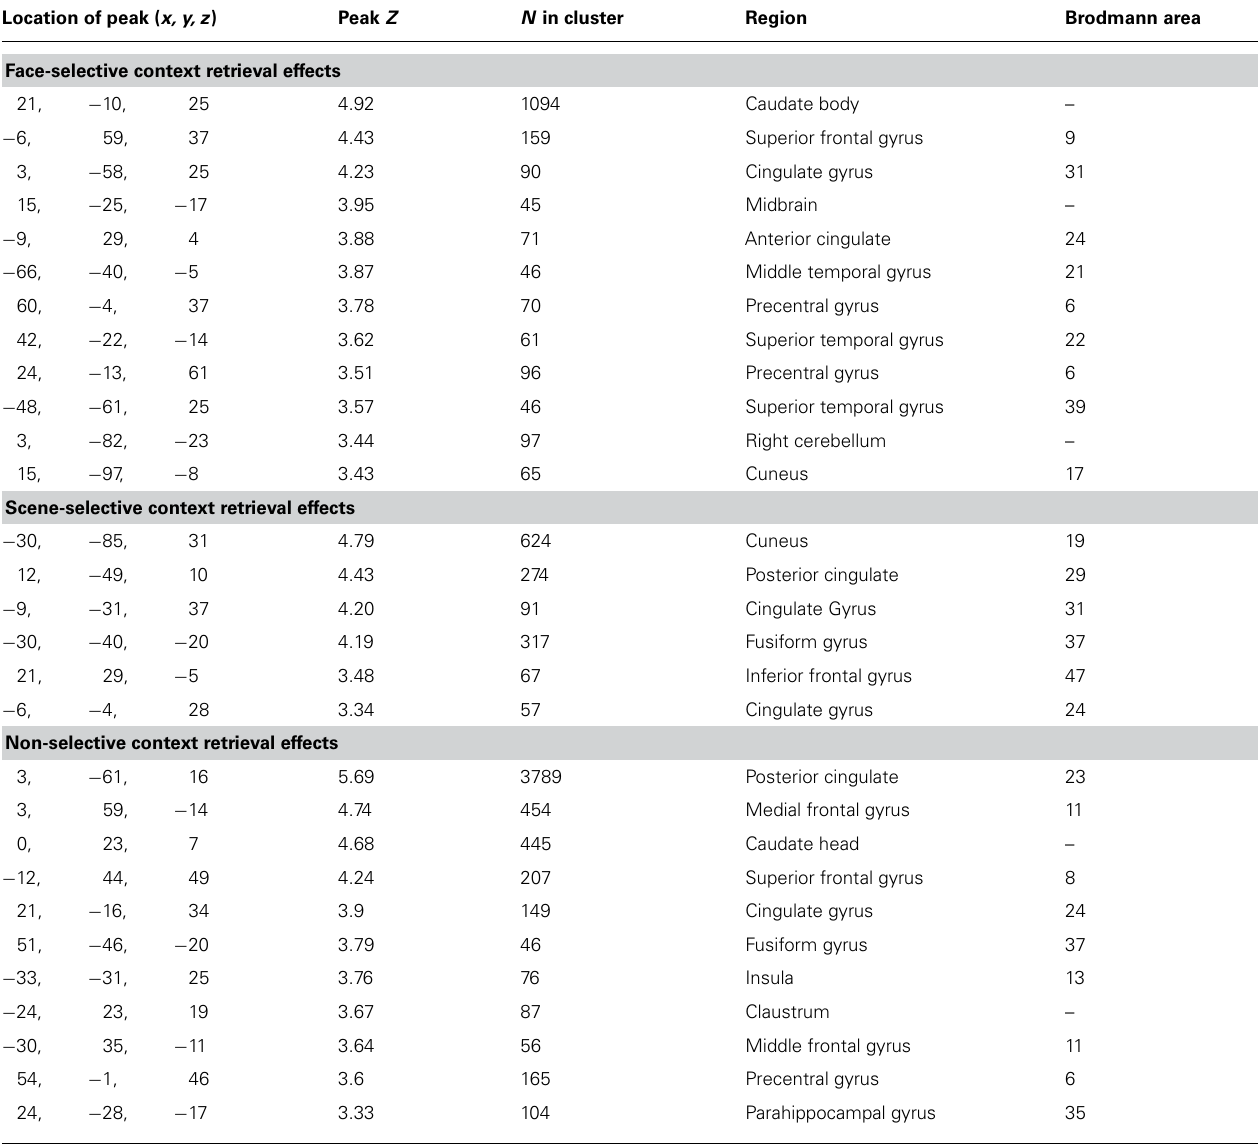
Table 2 | Retrieval success: selective and generic contextual retrieval effects. Location of peak ( x, y, z ) Peak